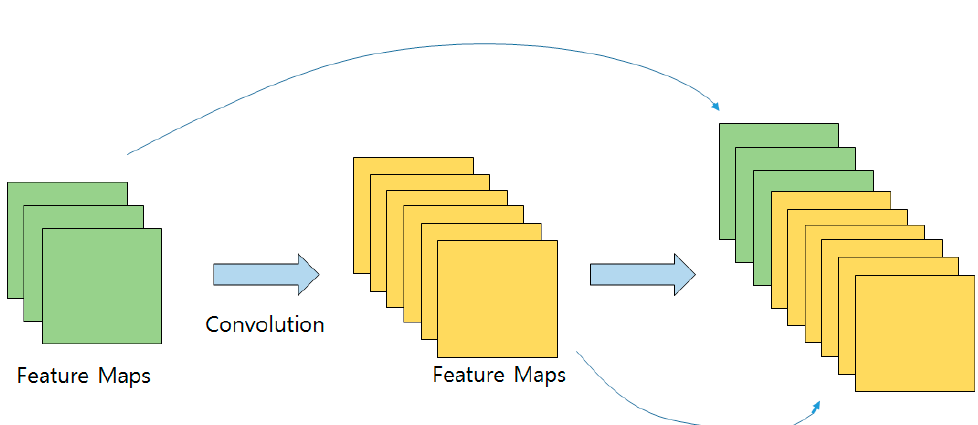
Figure 3. Dense connectivity.